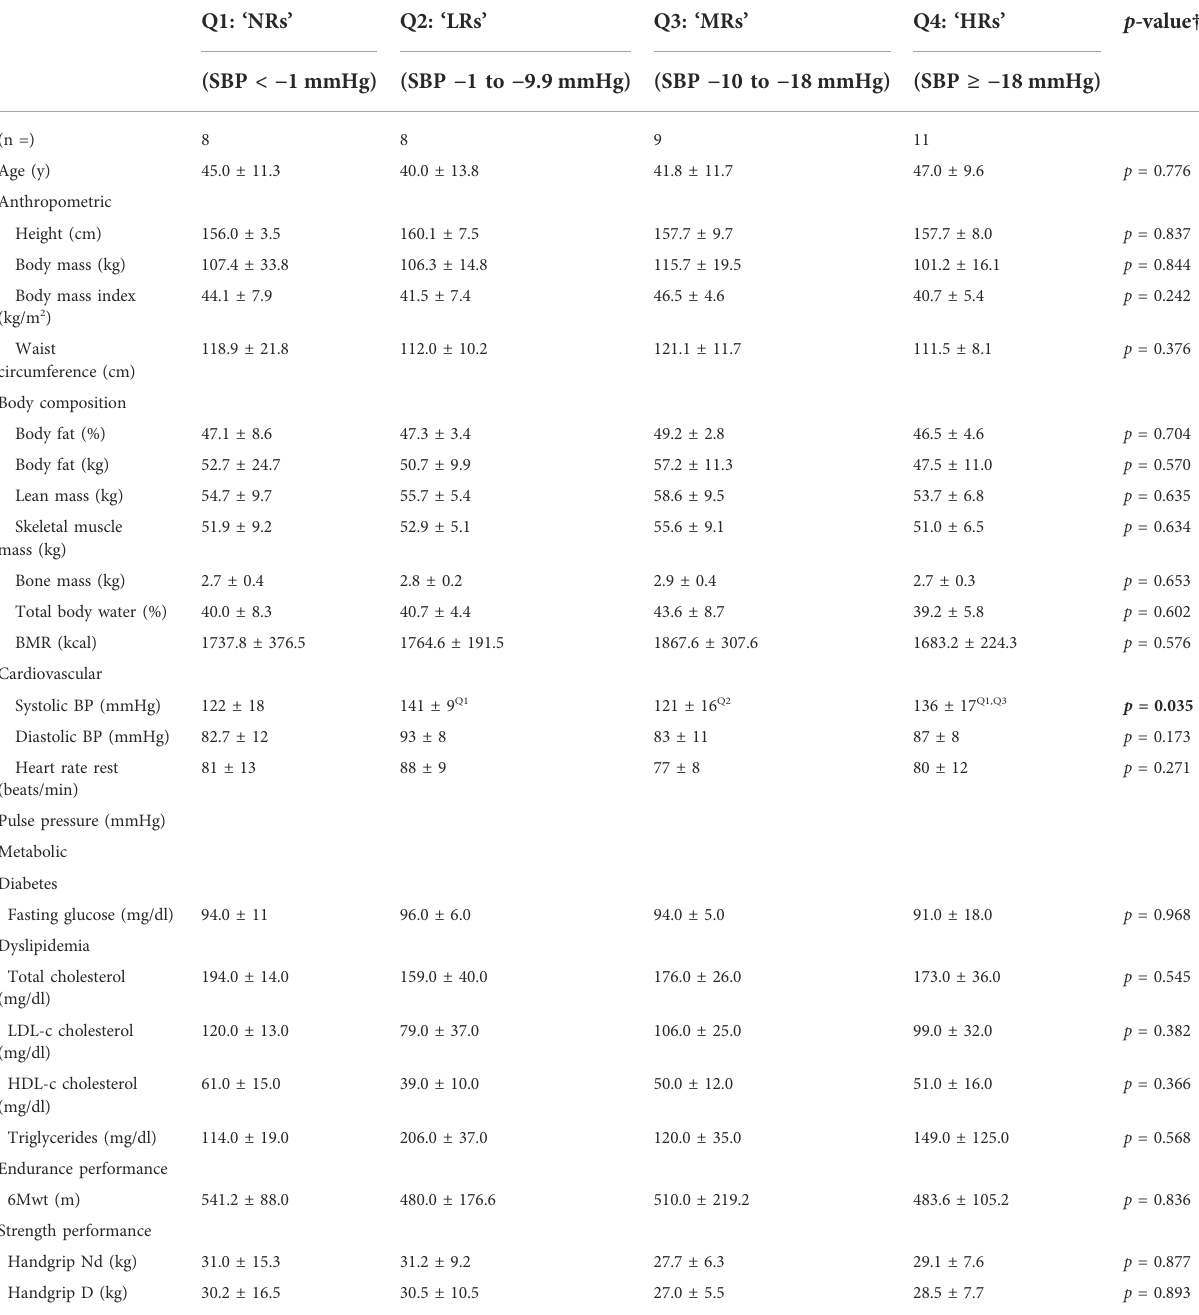
TABLE 2 Responders and nonresponders for post-exercise hypotensive effect by decreasing systolic blood pressure after 20 weeks of two orders of concurrent